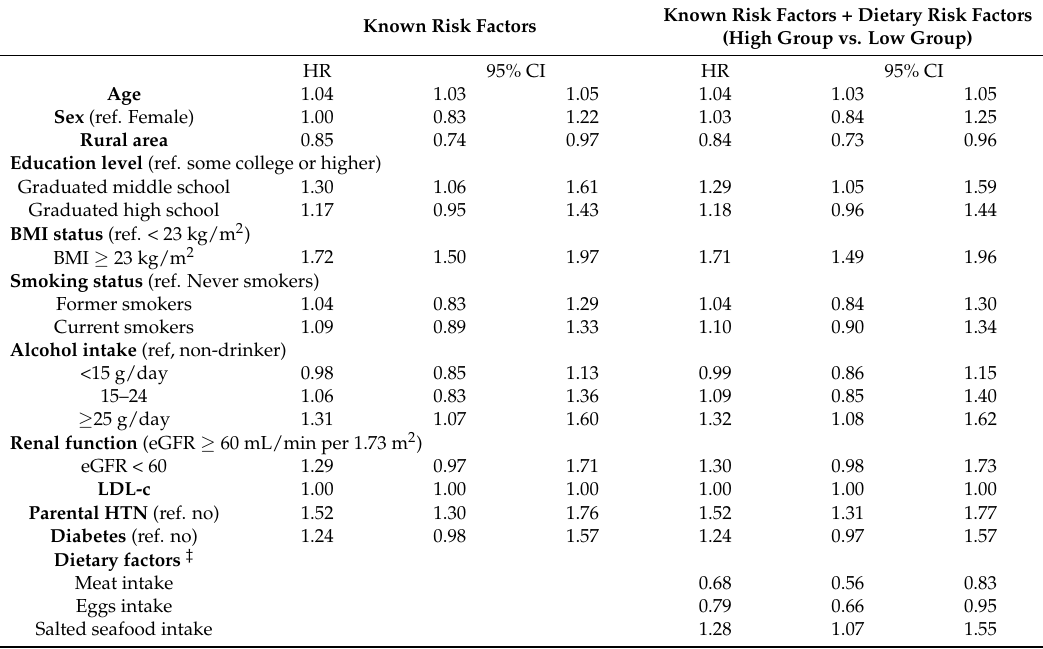
Table 2. Effects of potential risk factors on the incidence of HTN † .